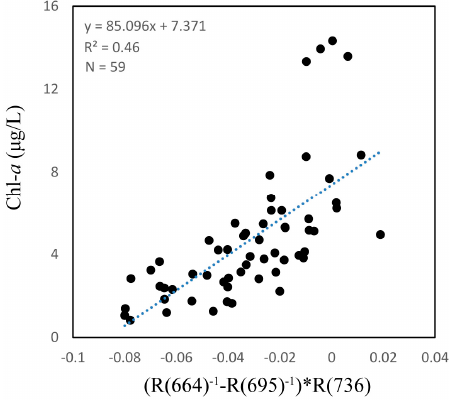
Figure 4. Correlation between the three-band model algorithm and measured chlorophyll a (Chl- a ).